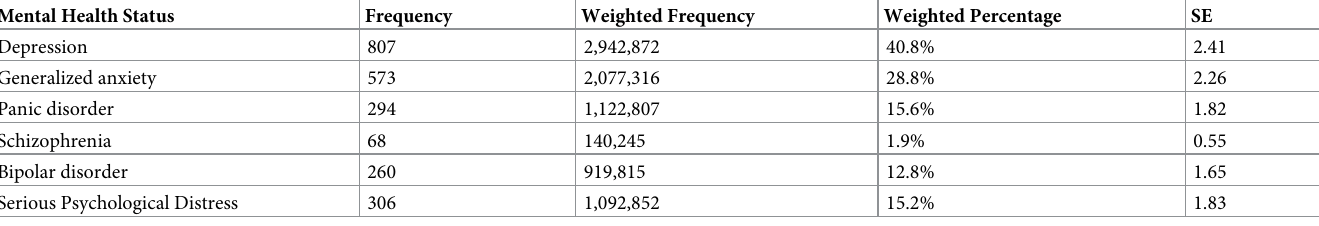
Table 2. Mental health conditions of female patients of reproductive age (15–49 yrs) served at HRSA funded health